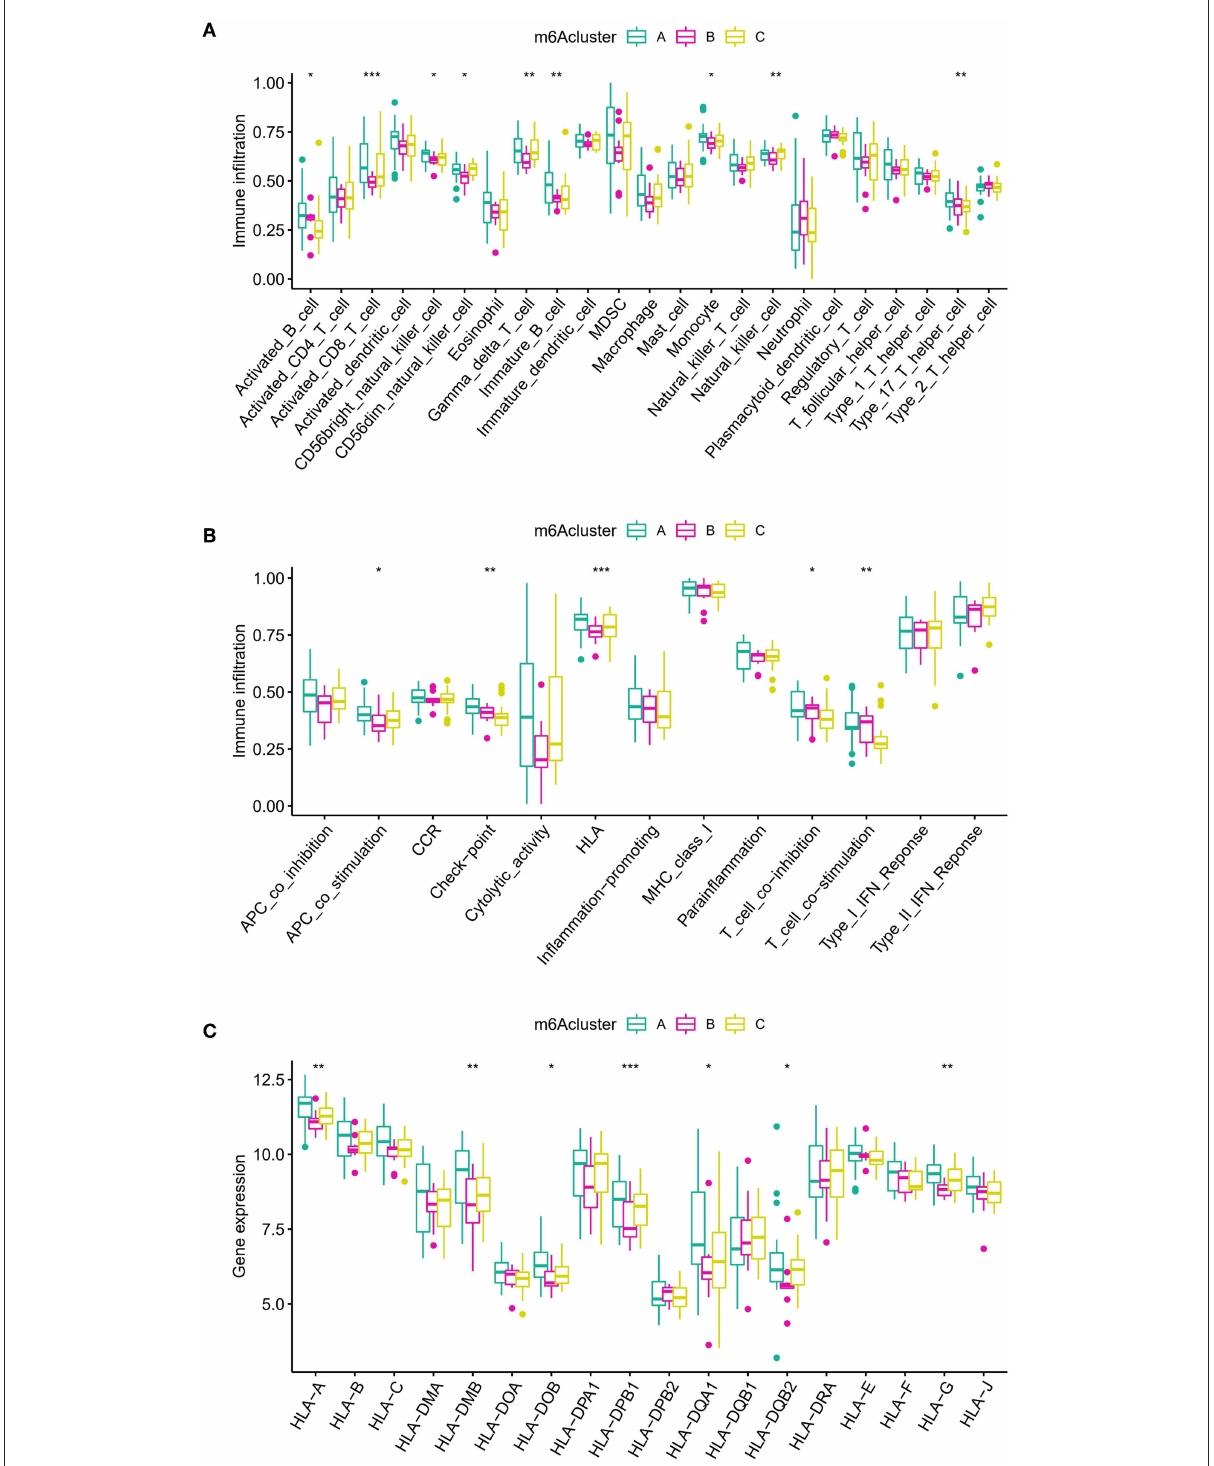
FIGURE7 Diverse aspects of the immunological microenvironment associated with various m6A modification patterns. (A) Differences in the abundance of each immunological microenvironment infiltrating immunocyte in three different m6A modification patterns. (B) Differences in the activity between each immune response gene in three m6A modification patterns. (C) Differences in the expression level of each HLA gene across three m6A modification patterns. The symbols * , ** , and *** indicates the value of p < 0.05, p < 0.01, and p < 0.001